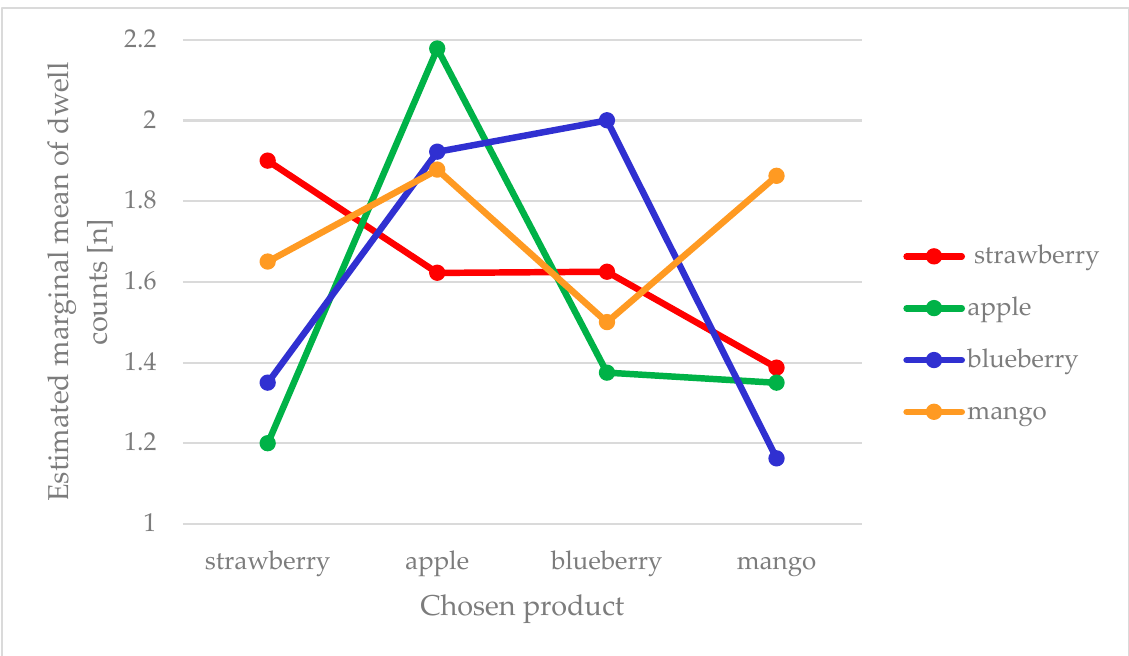
Figure 3. Dwell counts of the four yoghurt product alternatives. The length of the first fixation did not influence other eye-tracker parameters, so no higher values were recorded for FD, FC, DD and DC when the strawberry odor was present. However, the choice frequency of products was partially influenced by the odor in the case of chocolates ( χ 2 = (3,6) = 13.675, p < 0.05) and yoghurts ( χ 2 = (3,6) = 110,077,703, p < 0.001). For chocolate products, strawberry-, raspberry- and Oreo-flavored alternatives received higher choice frequencies when the odor was present, while the peanut-flavored alternative was chosen less frequently. For yoghurts, participants chose strawberry-